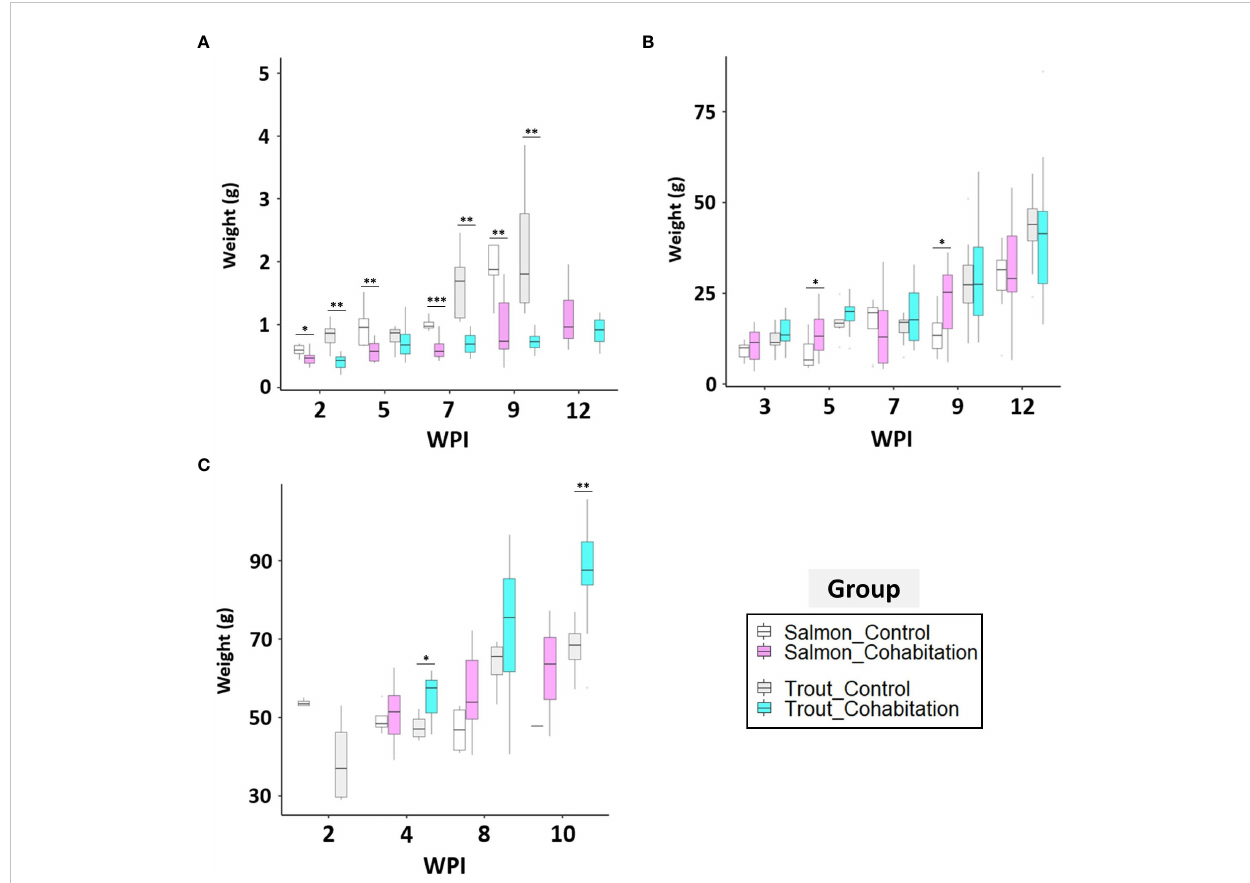
FIGURE 10 Box and whisker plots for the weight of the control and PRV-1 challenged groups. The box indicates median weight, interquartile range (IQR) and the whiskers indicates ranges of plus or minus 1.5 times IQR. The comparison between control and cohabitation ( A ; fry, B ; parr, and C ; post-smolt) for salmon and brown trout. Asterisk (* P < 0.05; ** P < 0.01; *** P < 0.001) indicate signi fi cant differences between same species of control and cohabitated group based on Welch ’ s two sample t-test.